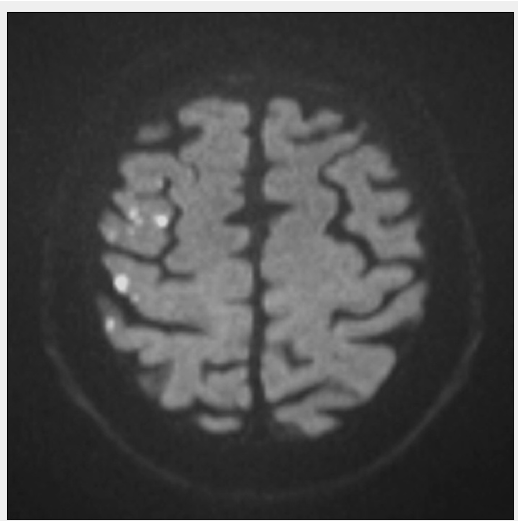
Figure 3 Diffusion weighted MRI of a patient following stenting of the right carotid artery in the MRI substudy of the International Carotid Stenting Study. Multiple hyperintense signals representing acute ischaemic lesions in the territory of the right middle cerebral artery are present. The patient did not experience any symptoms. © Department of Radiology, University Hospital Basel. Reprinted with kind